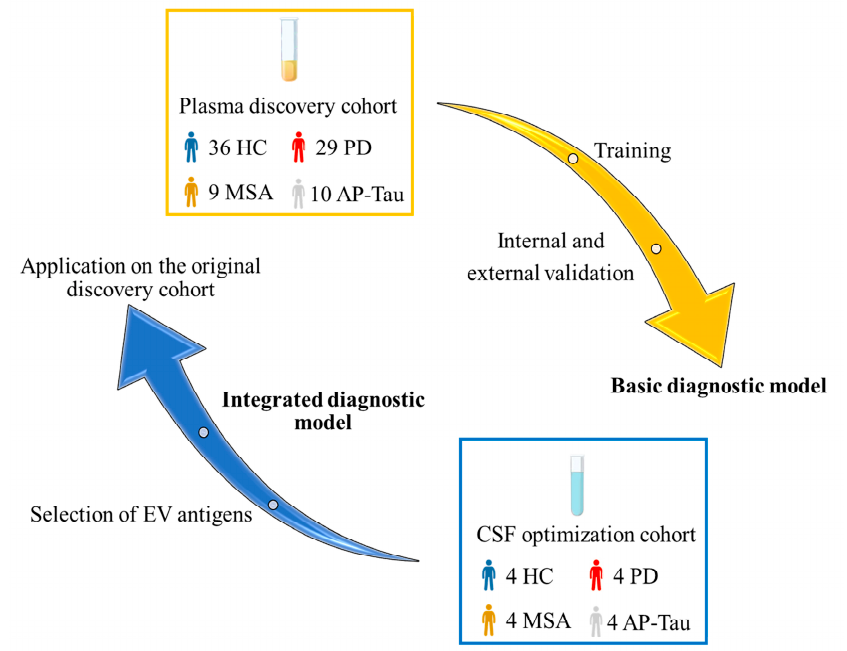
Figure 2. Study flowchart. The plasma discovery cohort was used to train and validate the basic diagnostic model based on plasma-derived extracellular vesicle (EV) profiling. The CSF-derived EV profiling in an optimization cohort was used to generate an integrated model that was subsequently tested in the discovery